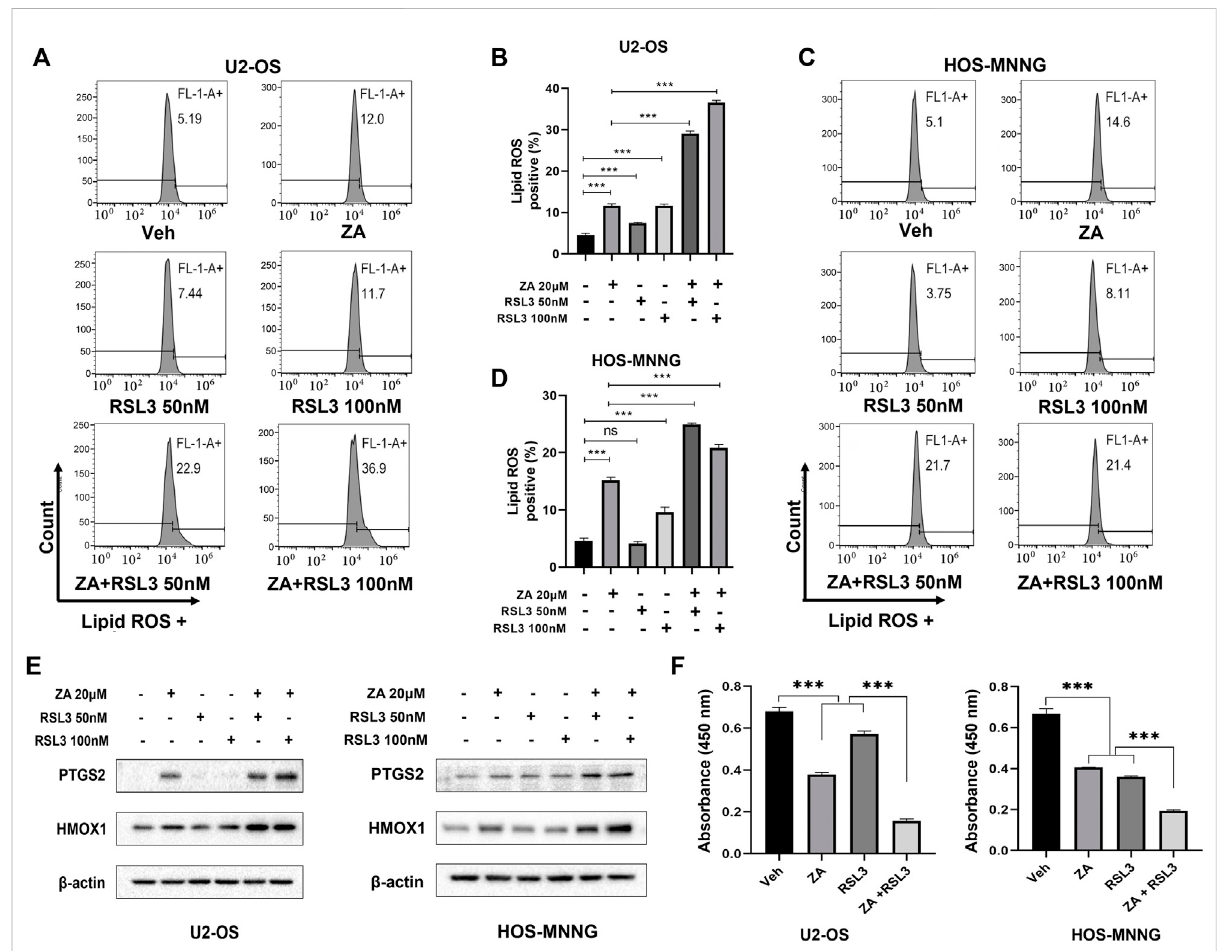
Ferroptosis inducer enhances zoledronic acid-induced ferroptosis and inhibition of cell growth in osteosarcoma cells. U2-OS (A, B) and HOS- MNNG (C,D) cells were treated with vehicle (Veh), ZA (20 μ M), or indicated concentrations of Ferroptosis inducer RSL3 alone or together for 24 h, and lipid ROS levels were analyzed (A,C) . (B,D) Quantitation of the fl ow cytometry data shown in (A,C) , respectively. (E) Cells were treated with zoledronic acid (20 μ M), RSL3 (50 nM, or 100 nM) alone or together for 24 h, and the protein levels of PTGS2 and HMOX1 were examined by western blot analysis. (F) RSL3 enhances ZA-induced inhibition of cell growth. Cells were treated with ZA (20 μ M) and RSL3 (100 nM) alone or together for 72 h before being analyzed by CCK8 reagent. The means ± SEM are indicated, n = 3. * p < 0.05, ** p < 0.01, *** p <